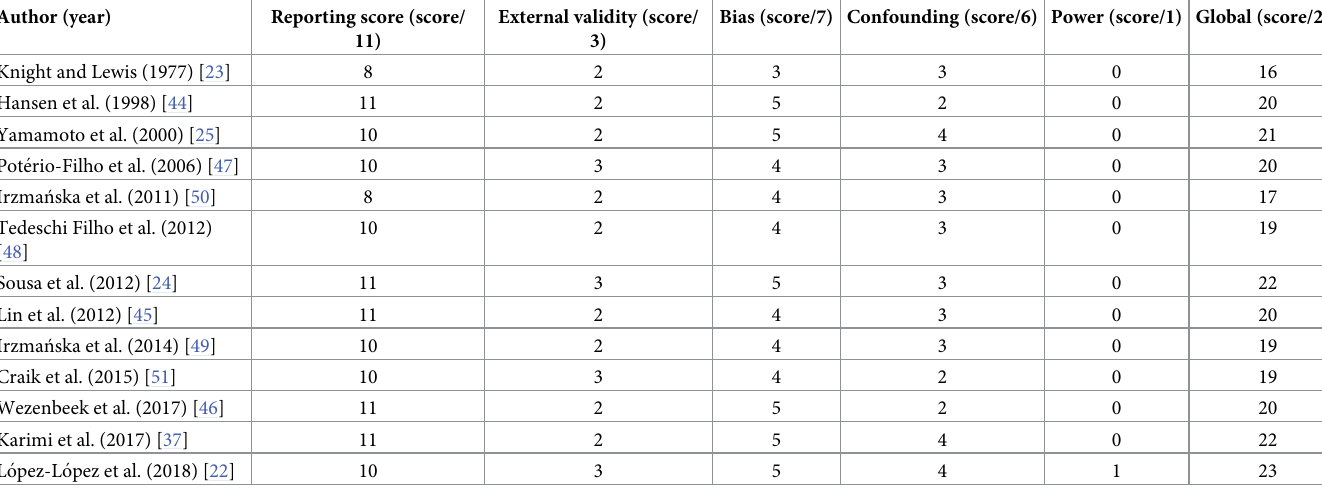
Table 3. Methodological quality of the included studies assessed by the quality index